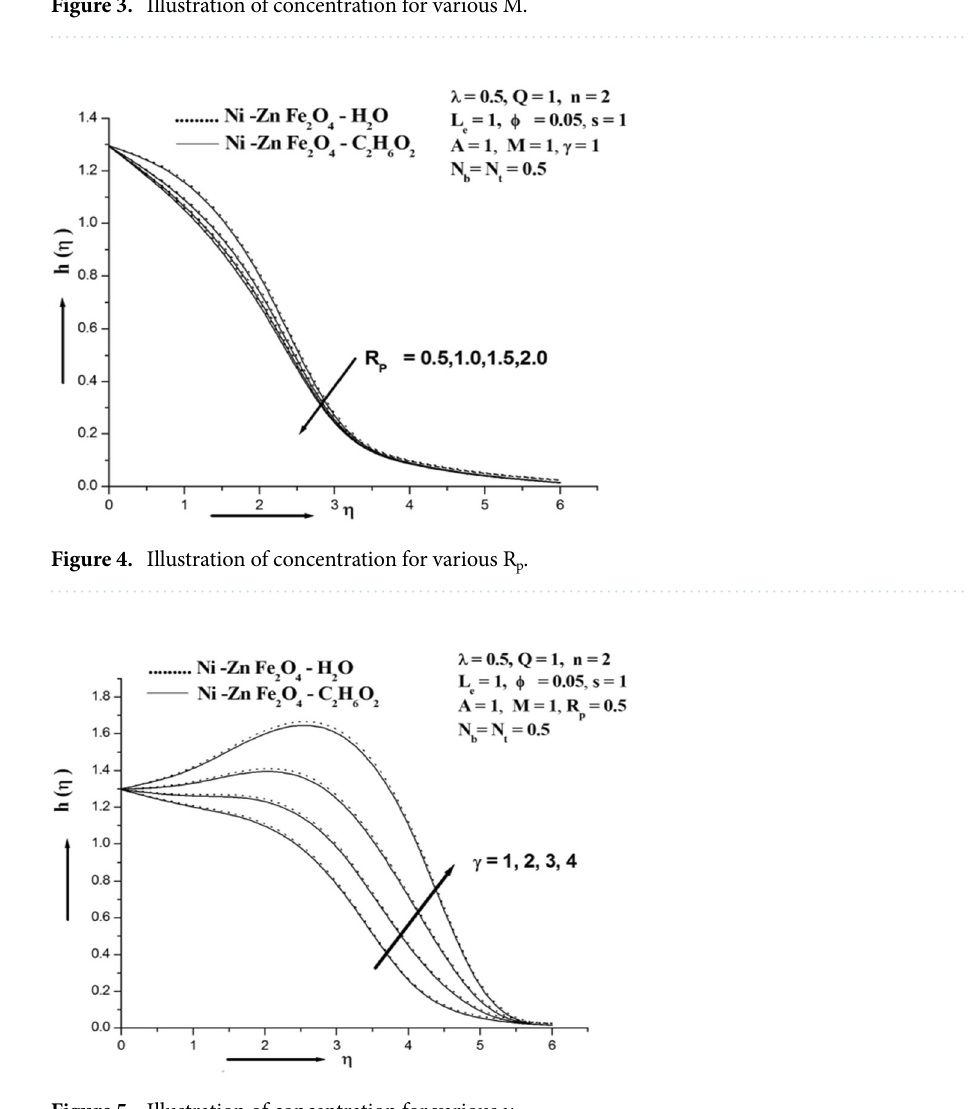
Figure 5. Illustration of concentration for various